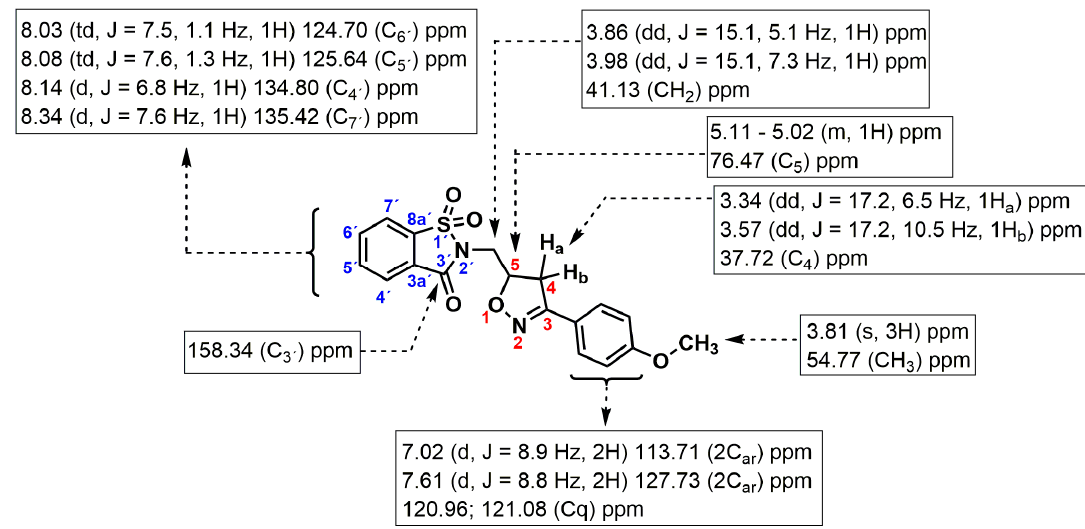
Figure 1. Characteristic 1 H, 13 C NMR of 3.